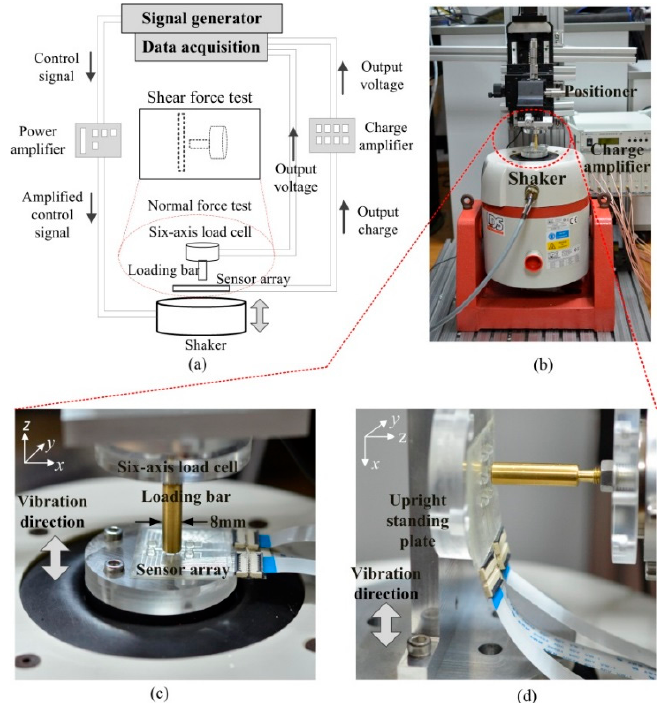
Figure 5. ( a ) Schematic of the experimental setup for sensor unit calibration.; ( b ) photograph of the experimental setup; ( c ) close-up view of the contact between the loading bar and PDMS bump in normal force loading; and ( d ) close-up view of the contact between the loading bar and PDMS bump in shear force loading.